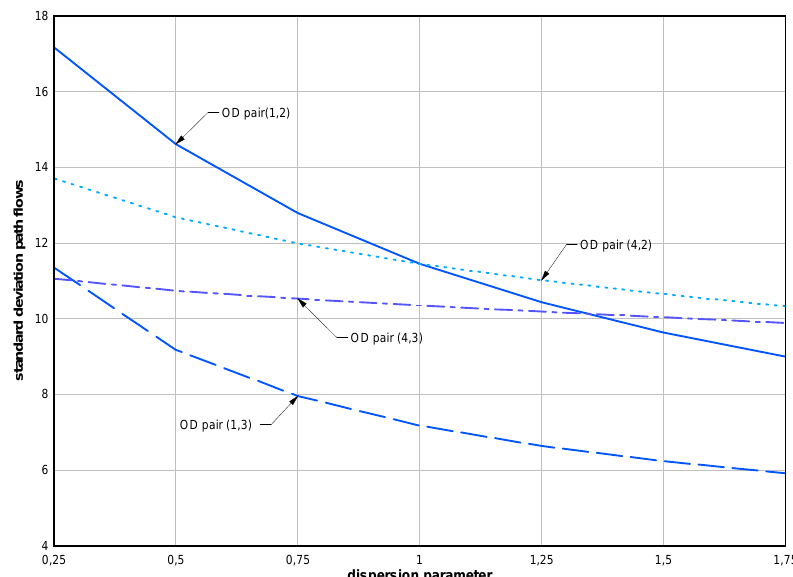
Figure 7. Variation of standard deviation of path flows with dispersion